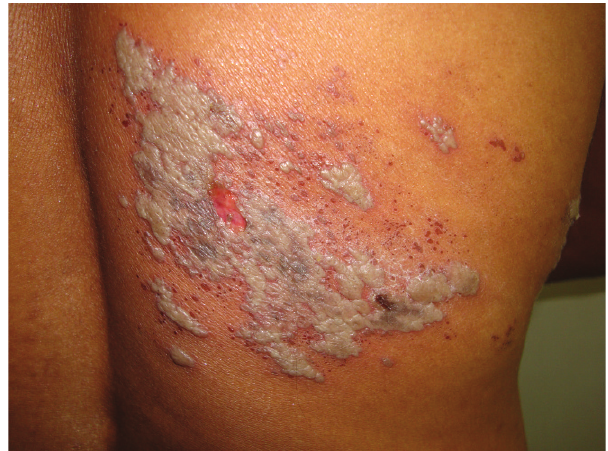
Figure 2 - Grouped erythematous vesiculous and crusted herpes zoster lesions on the right thoracic region along the intercostal nerve path – back